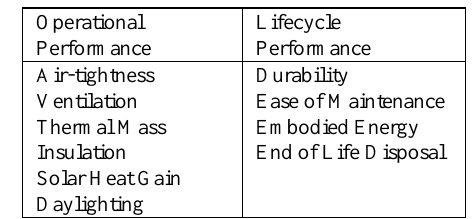
Table 1. Ten categories of sustainable performance